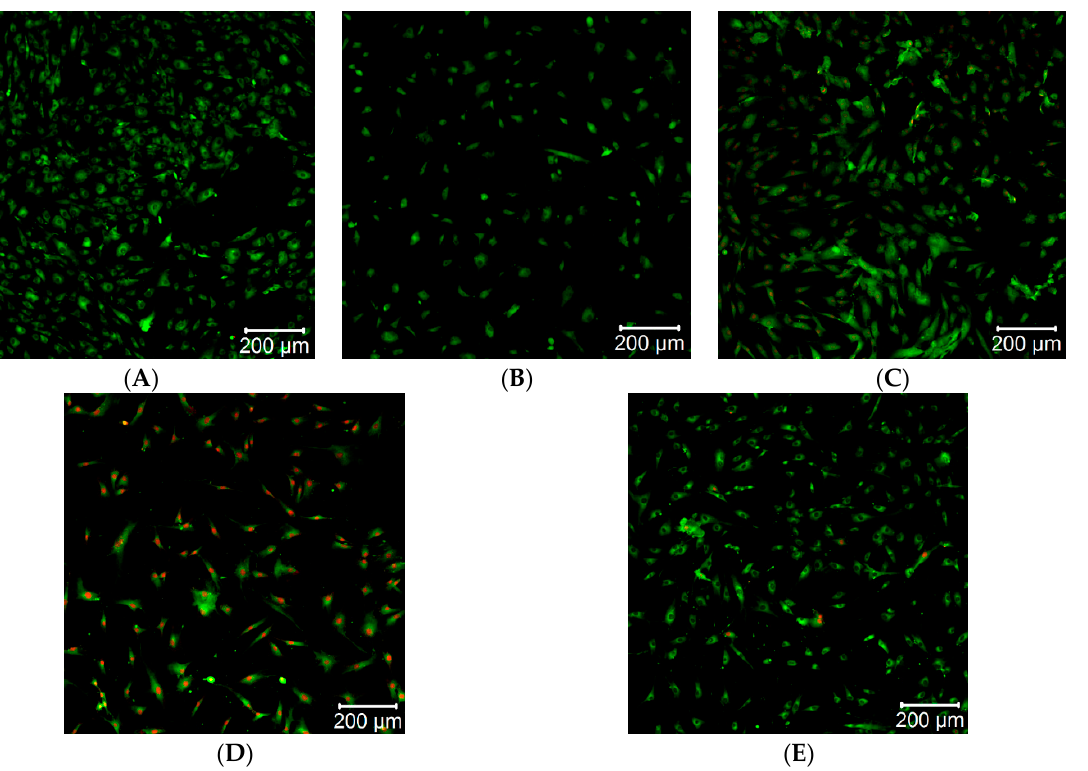
Figure 3. Images from confocal microscope of: ( A ) reference, ( B ) Ti/TiN + 5% Ag, ( C ) Ti/TiN + 7.5% Ag, ( D ) Ti/TiN + 10% Ag, ( E ) Ti/TiN + 15% Ag.